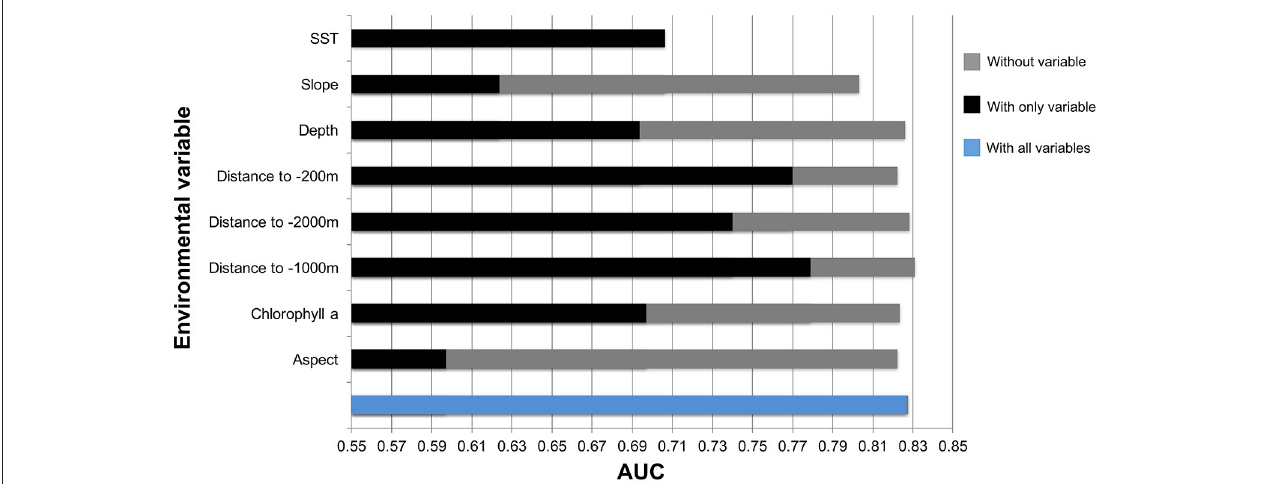
FIGURE 9 | Results from Jackknife tests showing the most influential environmental variables in the model. Values shown are averages over 25 replicate runs in Maxent.